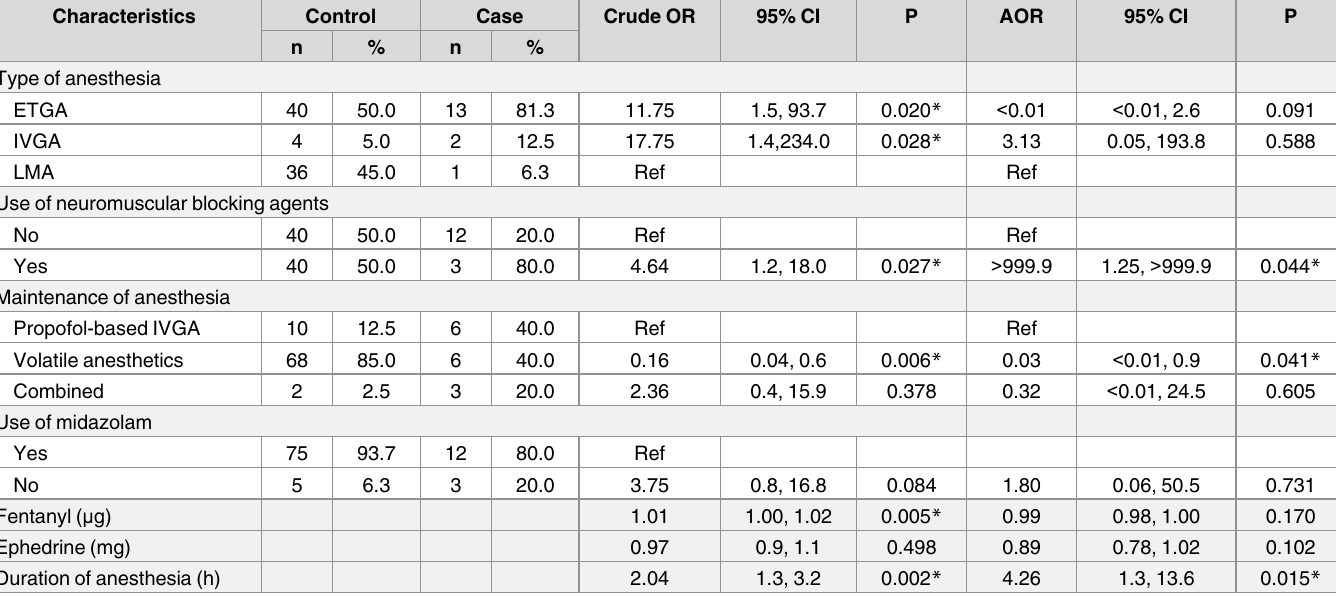
Table 5. Conditional logistic regression analysis of the risk factors associated with awareness.